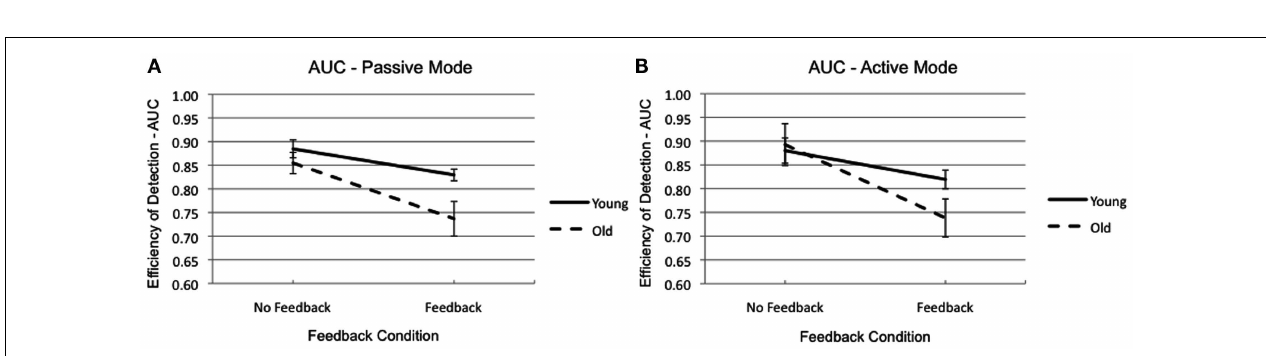
FIGURE 5 |TheAUC of younger (solid line) and older (dashed line) participants depending on feedback condition and movement mode [(A) passive and (B) active]. The error bars represent the standard